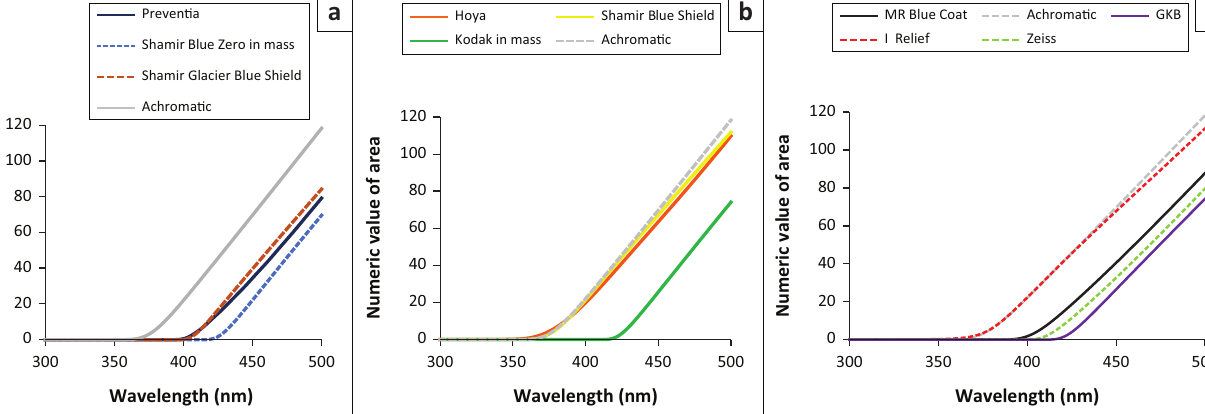
Table 2 represents the area of the light transmitted under each curve in Figure 3 and is represented by a number for wavelengths ≤ 460 nm (shorter) to where the transmission starts as well as for wavelengths between 460 nm and 500 nm (longer). The achromatic control lens has the largest area beneath its transmission curve (118) followed by the Shamir Blue Shield (112), i-Relief (111) and then the Hoya Blue Control (110) which all have values greater than 100. Shamir Blue in mass (70) has the smallest area followed by the Kodak and GKB (74). This is followed by Prevencia (79), Zeiss Blue Protect (80), Shamir Glacier (84) and then the MR Blue Coat (88). It can be seen that the lenses showing the smaller areas also have a smaller range. The first number in the brackets in Table 2 represents the shortest wavelength whereby transmission begins. For wavelengths ≤ 460 nm, from Table 2 we see that the control lens (achromatic) has the largest area for wavelengths